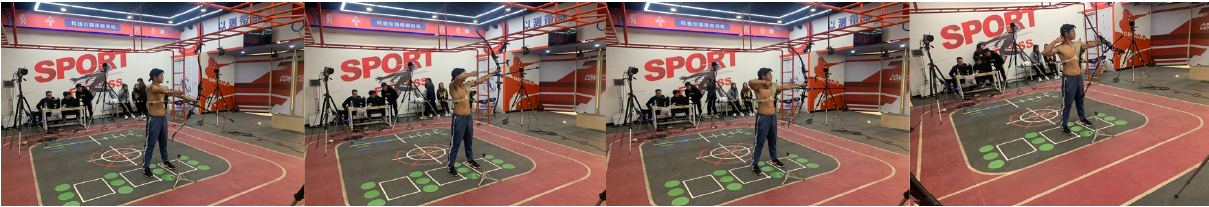
Fig. 1. Four characteristic actions of the recurve bow (the start of raising the bow, the start of drawing, holding, the end of releasing